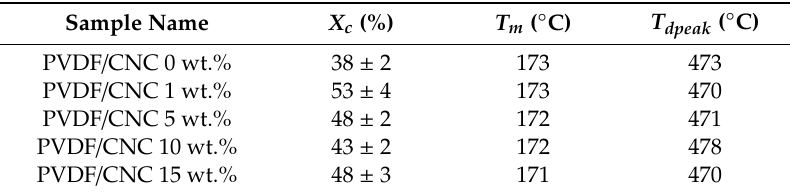
Table 2. Crystalline fraction ( X c ), melting temperature ( T m ), and maximum degradation temperature ( T dpeak ) for the PVDF / CNC nanocomposites.